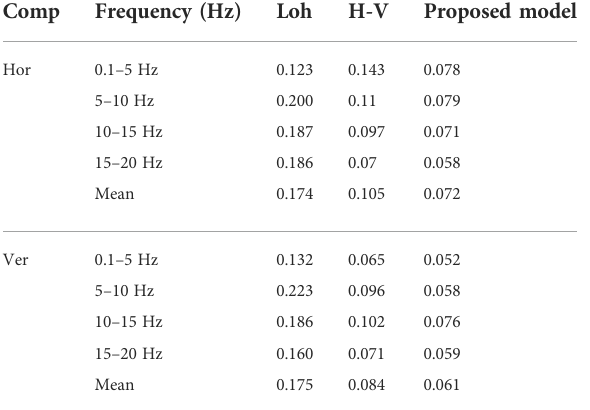
TABLE 4 RMSE of different models ’ fi tting results for the Luxian Earthquake. Comp Frequency (Hz) Loh H-V Proposed model